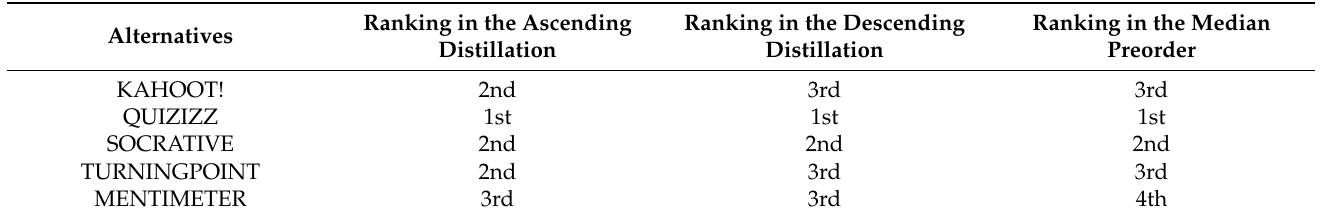
Table 13. Rankings in the ascending and descending distillation and final ranking in ELECTRE III.